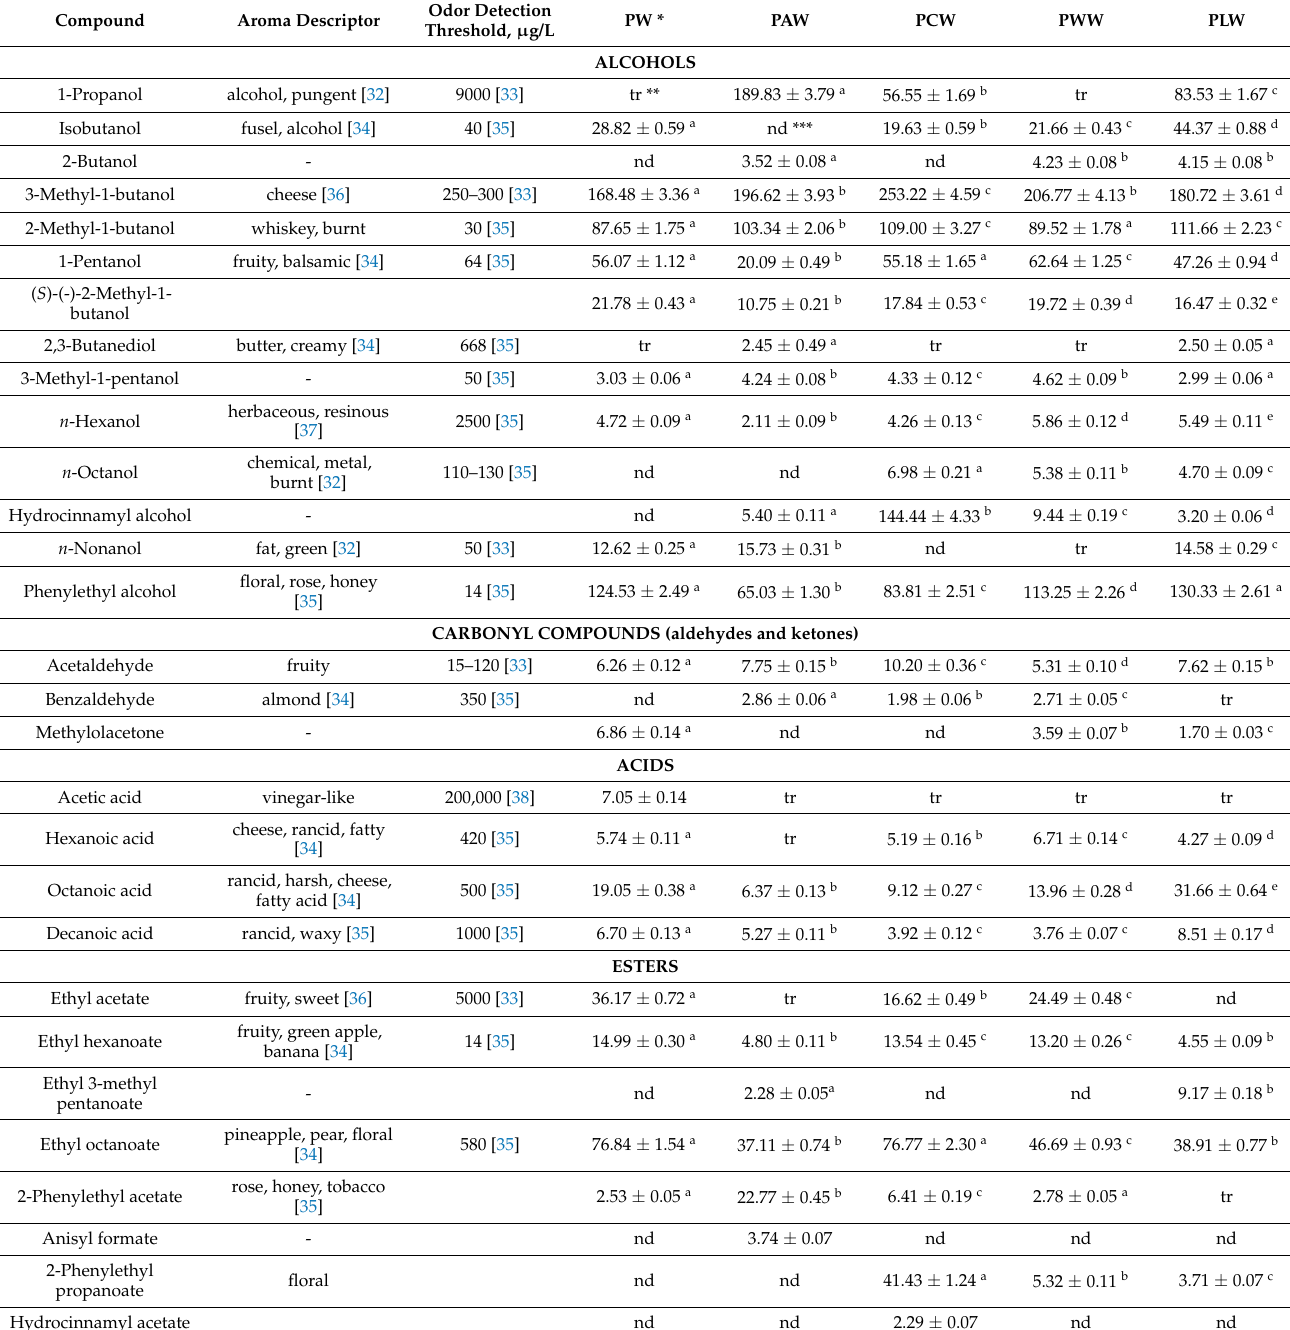
Table 1. Volatile organic compounds (in mg/L) in studied ‘Prokupac’ wines and aroma